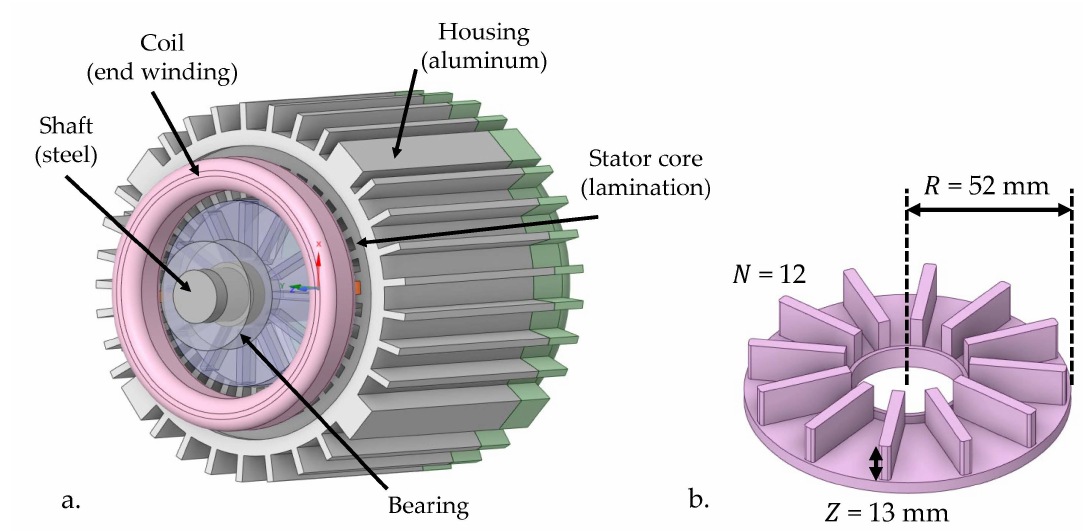
the outer rotor radius. The shaft radius is related to the outer rotor radius R (Table 4 and Figure 5) according to the standard IEC 60072 (Rotating electrical machines—Dimensions and output series). In order to reduce computational time, the coil representing the end winding was simplified and modeled with a toroid. The axial length of the stator core in the model was shortened (dimension l ss in Figure 6 and Table 4), as it had negligible effect on the thermal behavior in the end-winding region due to thermal insulation and low thermal conductivity in the axial direction (Table 5).